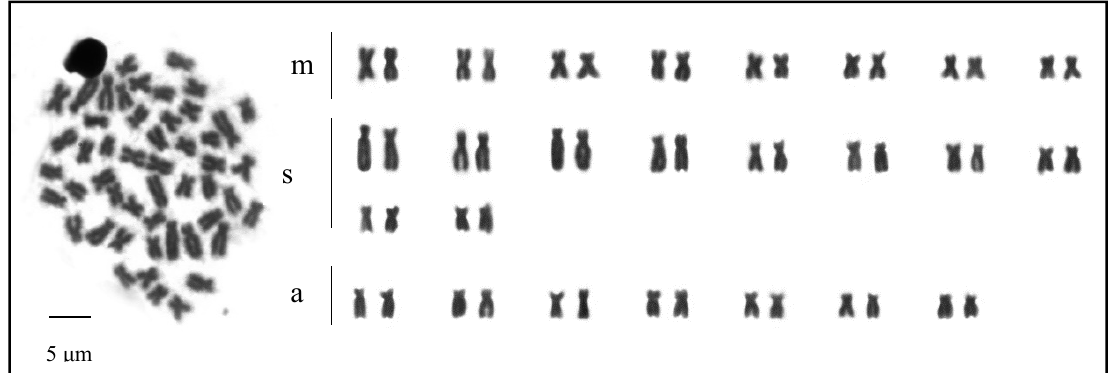
Figure 2. Karyotype of normal chromosome of O. vittatus (2n = 50). Remarks: metacentric (m), sub-metacentric (sm), acrocentric (a).